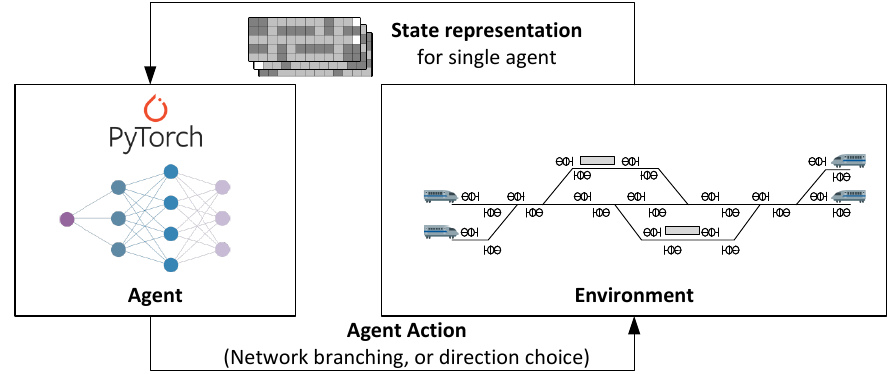
Figure 1. The reinforcement learning training